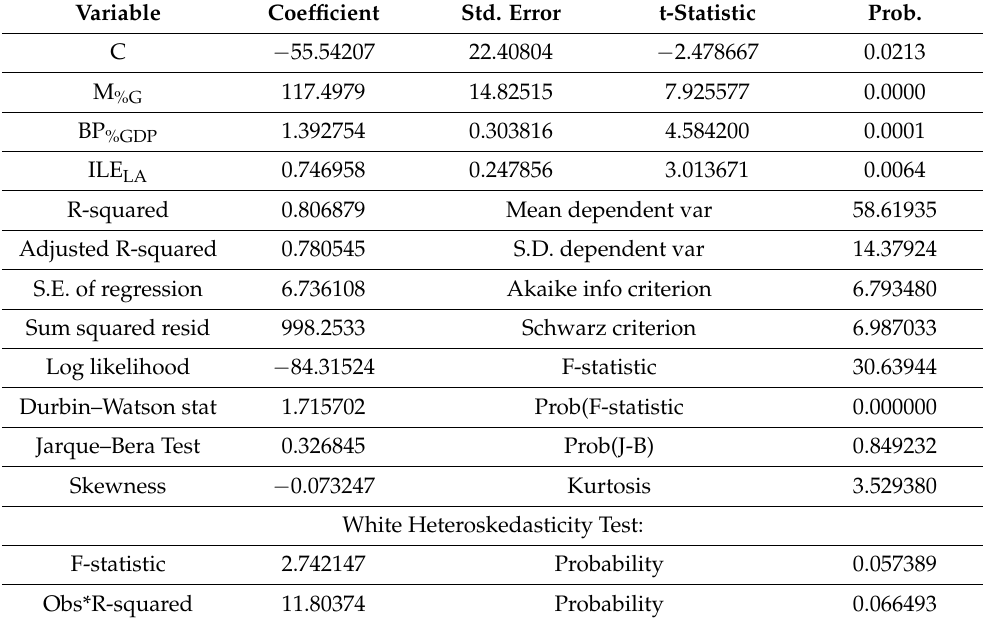
Table 4. S FDI_in(%GDP) model by M %G , BP %GDP and ILE LA for